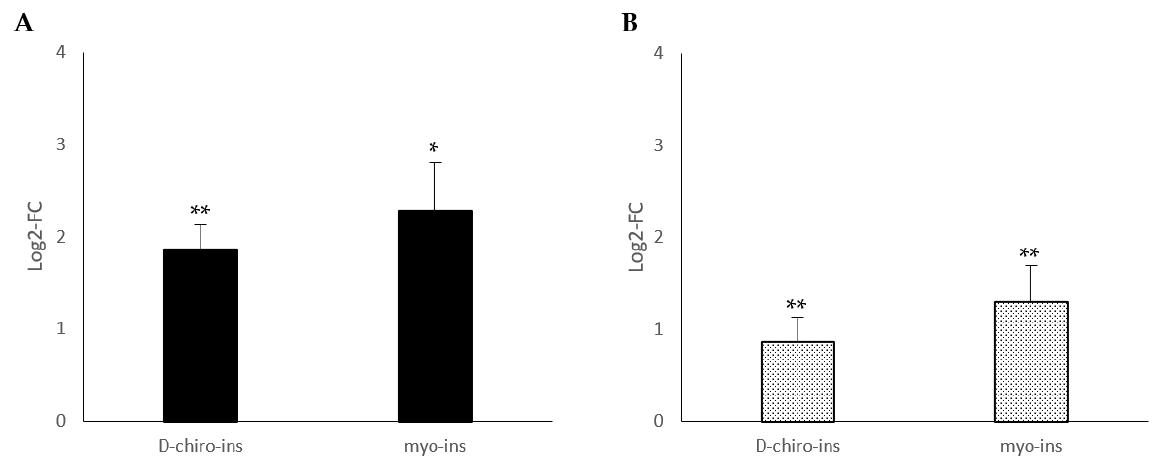
Figure 6. Modulation of the expression for the PPAR- γ variant 2 (PPAR- γ v2) messenger in ( A ) SGBS and ( B ) LiSa-2 adipocyte cells. D-chiro-Ins and myo-Ins concentrations used for the experiments were 60 µ M. Results are reported as mean ± SD of data obtained from 3 independent experiments in technical triplicate. Bars show log 2-fold change (treated vs. control). Data were analyzed by one-way ANOVA with repeated measures followed Duncan–Waller post hoc test. p -values ≤ 0.05 were considered statistically significant. * p < 0.05 versus control; ** p < 0.01 versus control.